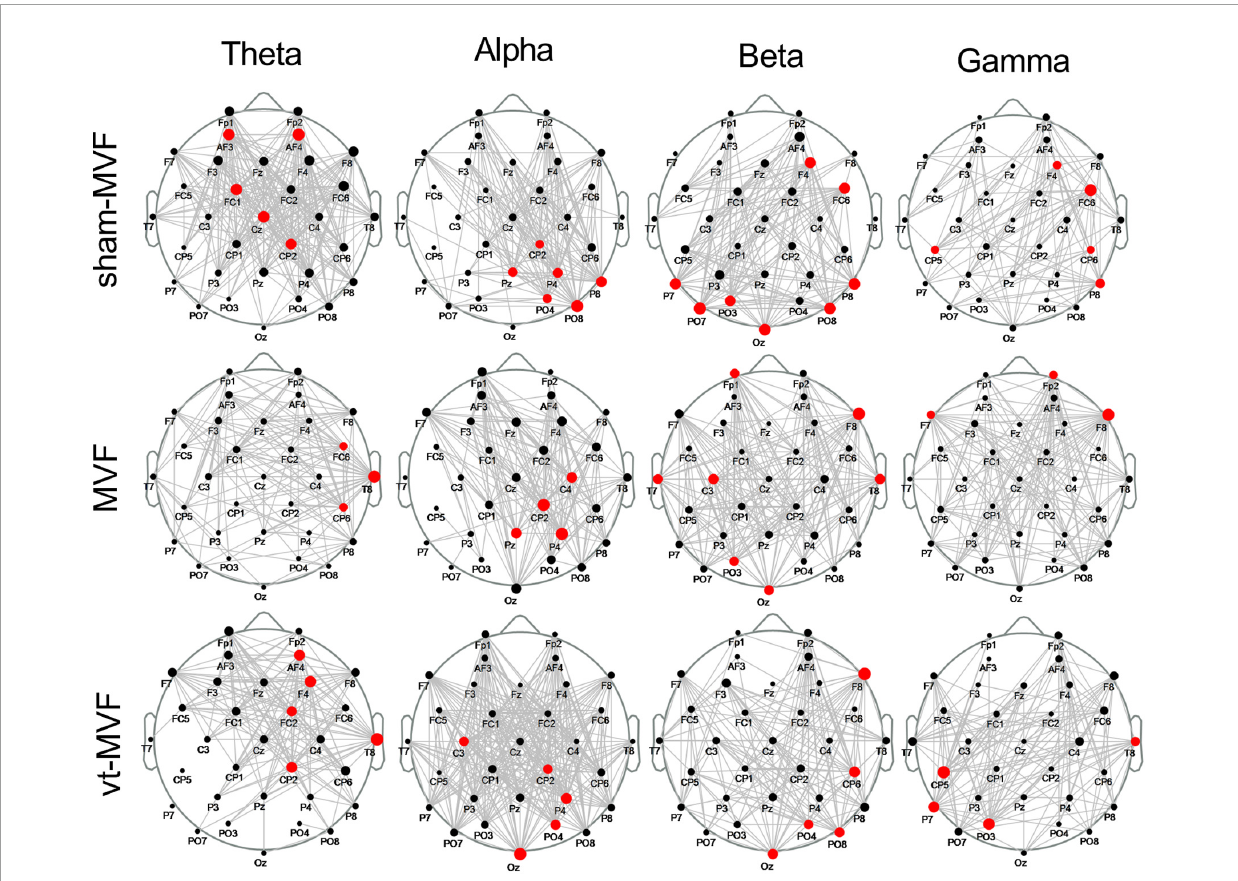
FIGURE3 Scalp network topology of the sham-mirror visual feedback (MVF), MVF, and vt-MVF experimental condition in theta (4–8 Hz), alpha (8–13 Hz), beta (13–30 Hz), and gamma (30–40 Hz) frequency band. The bigger dot on each node (electrode location) indicates the larger node degree within this network. Note that the hubs are marked in red.